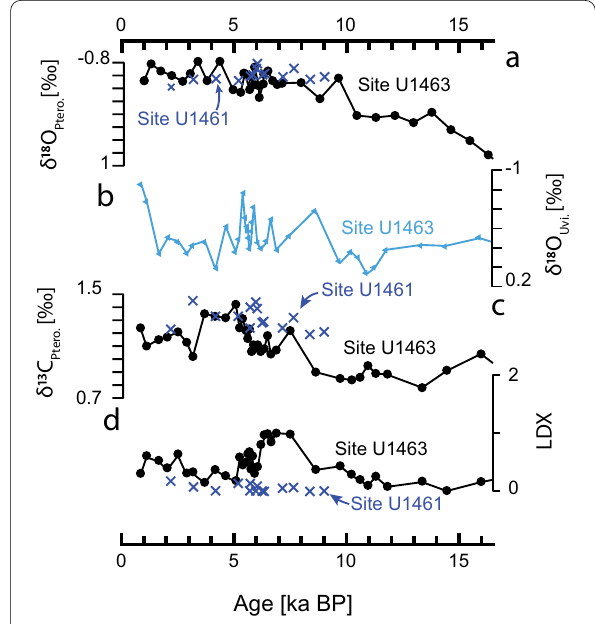
Fig. 3 Isotope values and Limacina dissolution index (LDX) data for IODP Sites U1461 and U1463. ( a ) δ 18 O values of pteropods ( H. inflatus ) from Sites U1461 and U1463. ( b ) δ 18 O values of the benthic foraminifera Uvigerina spp. from Site U1463. ( c ) δ 13 C values of pteropods ( H. inflatus ) from Sites U1461 and U1463. ( d ) LDX values of pteropods from Sites U1461 and